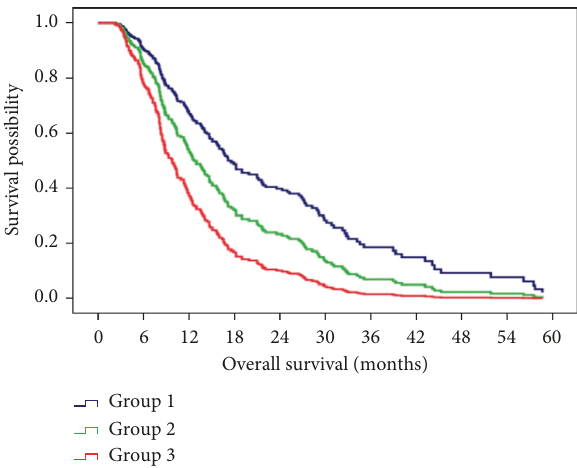
Figure 1: The difference in survival with combination therapy of TACE and sorafenib after dividing patients into 3 groups based on diarrhea and HFSR-response. Group 1, complete responders; Group 2, partial responders; Group 3,